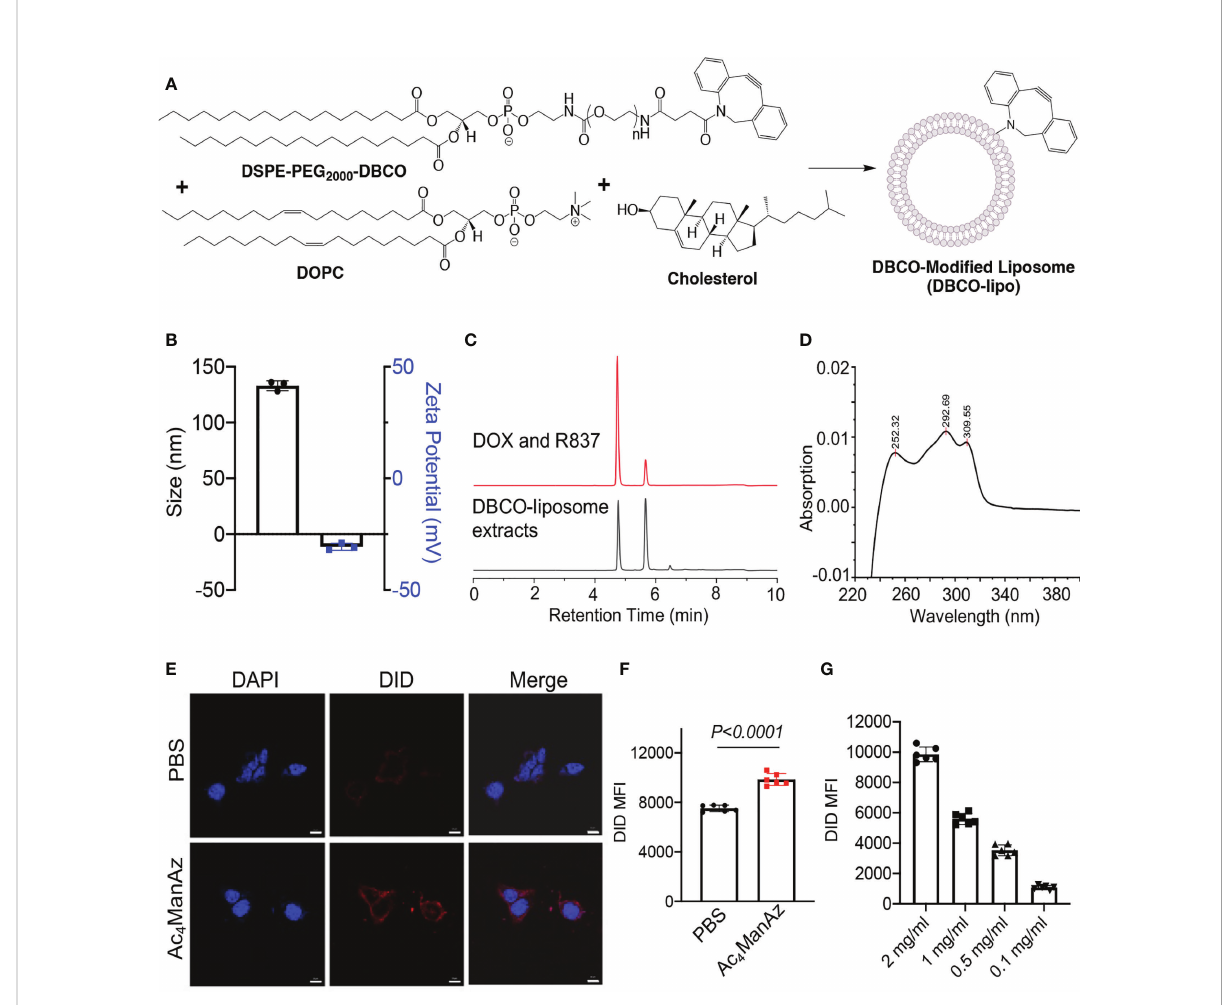
FIGURE 2 Synthesis, characterization, and in vitro targeting effect of DBCO-modi fi ed liposomes. (A) Schematic illustration of the synthesis of DBCO- modi fi ed liposomes from DSPE-PEG 2000 -DBCO, DOPC, and cholesterol. Unmodi fi ed liposomes were synthesized using DSPE-PEG 2000 . (B) Size and zeta potential of DBCO-lipo. (C) HPLC traces of a mixture of Dox and R837 or the extracts of Dox/R837-encapsulating DBCO-lipo. The detection wavelength was set at 254 nm. (D) The UV absorption spectrum of DBCO-lipid as detected at ~6.5 min in (C) . (E) Confocal images of 4T1 cells pretreated with Ac 4 ManNAz or PBS for 48 h and then incubated with DID-encapsulating DBCO-lipo for 30 min. Scale bar: 10 m m. (F) Mean Cy5 fl uorescence intensity of 4T1 cells pretreated with Ac 4 ManNAz or PBS for 48 h and then incubated with DID-encapsulating DBCO-lipo (2 mg/ml) for 30 min. (G) Mean Cy5 fl uorescence intensity of 4T1 cells pretreated with Ac 4 ManNAz and then incubated with different concentrations of DID-encapsulating DBCO-lipo for 30 min. All the numerical data are presented as mean ±